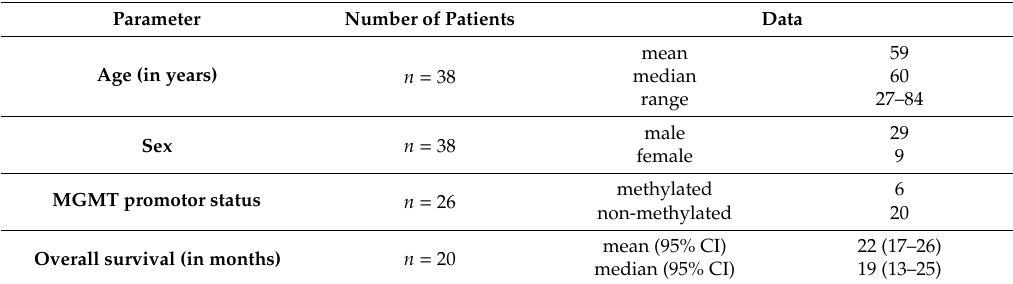
Table 2. Patient